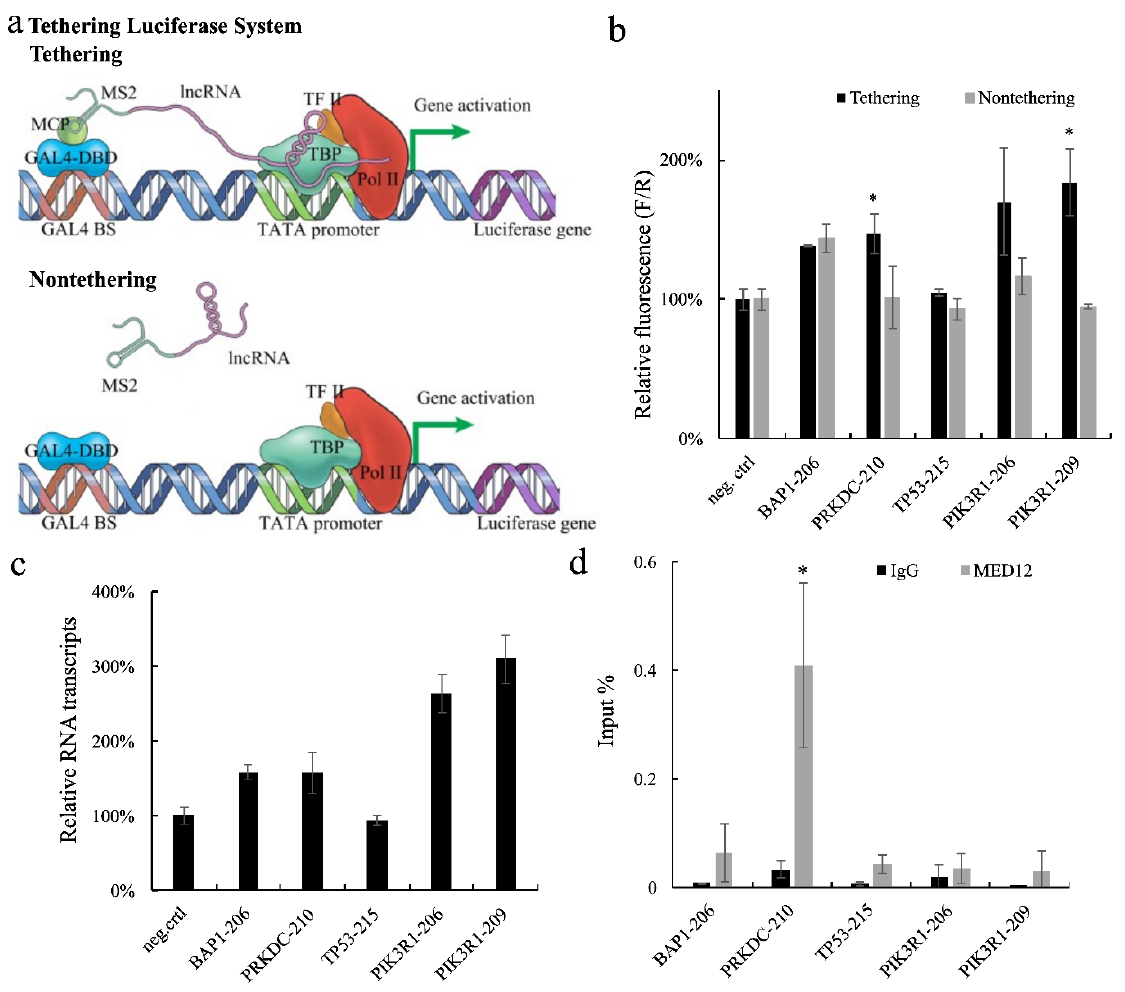
Figure 1. ( a ) Schematic illustration of the tethering luciferase assay system. ( b , c ) Tethering luciferase assay using HEK293T cells, relative fluorescence and mRNA levels were detected. We used the empty MS2 plasmid instead of the MS2 lencRNA plasmid as negative control (neg.ctrl). Value = sample/neg.ctrl. ( b ) We used the Dual-Luciferase ® Reporter assay to detect the results of the tethering assay; the luciferase gene expression levels of different lencRNAs in the tethering or nontethering were compared. F/R, Firefly luciferase/Renilla luciferase. ( c ) Total RNA was extracted from cells transfected with tethering luciferase assay plasmid, and the differences of luciferase mRNA transcript between different lencRNAs were compared. Total RNA was reverse-transcribed into cDNA using random primers and quantified by qPCR using specific primer for luciferase gene. ( d ) The binding of different lencRNAs to MED12 in MCF7 cells was compared by RIP-qPCR assay. Value = sample/input. Data in all panels are represented as the mean ± s.e.m. of three independent experiments. * p < 0.05 by a two-tailed Student’s t -test (compared with nontethering ( a ) or IgG ( d )).